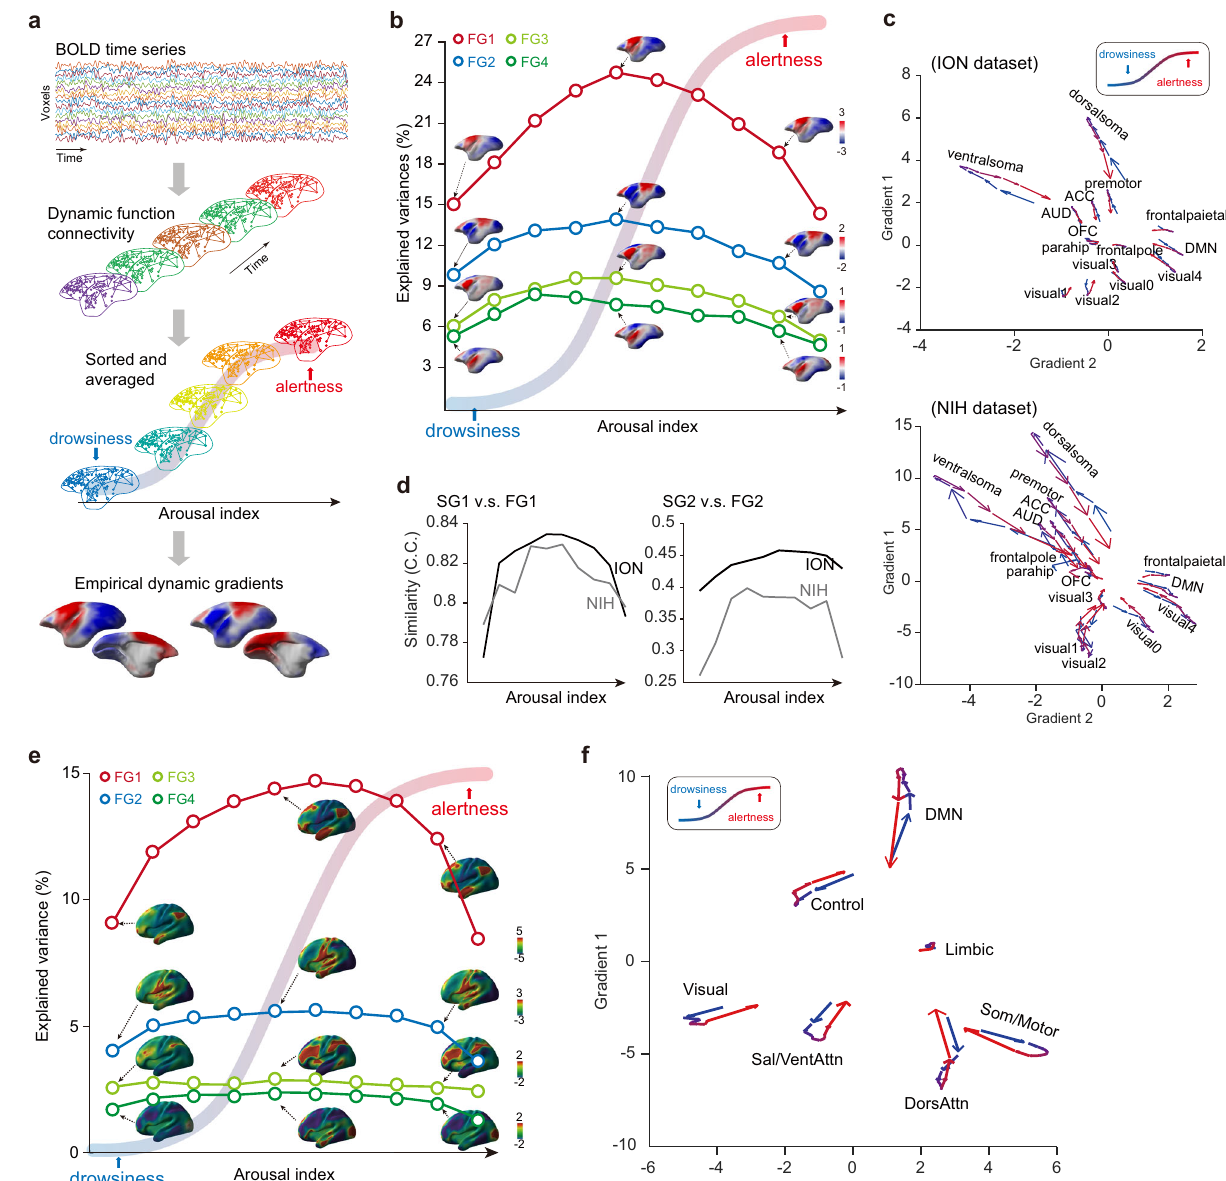
Fig. 3 | Arousal fl uctuation modulated functional gradient dynamics in mar- mosetandhuman.a Pipeline for estimating arousal relevant dynamic function gradients. For each scan, we obtained dynamic connectivity matrices using the dynamic conditional correlation strategy 35 . After binned by the arousal index, connectivity matrices were averaged and projected into dynamic function gradients, respectively. b Inverted U-shape relationship between arousal level and explained variance across gradients. Details were shown in Supplementary Fig. 14. c Arousal relevant fl ow of each network in gradient